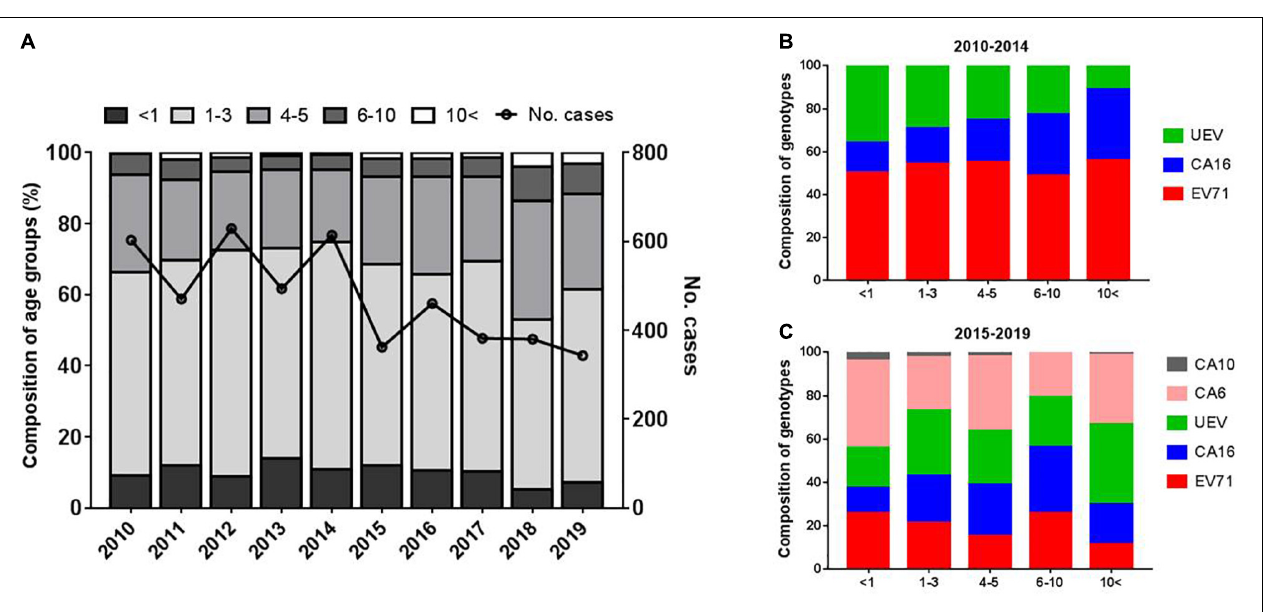
as Category 2 vaccine in the National Immunization Program (NIP). A total of 55,632 children were vaccinated in 2017, with a significant decrease in the proportion of EV-A71 infections ( Supplementary Figure 1 ). In 2018, the number of vaccinations ( n = 102,145) almost doubled compared to the previous year, with only 2 cases of EV-A71-related cases. Later, EV-A71-related cases has not been reported since August 2018. In 2019, a total of